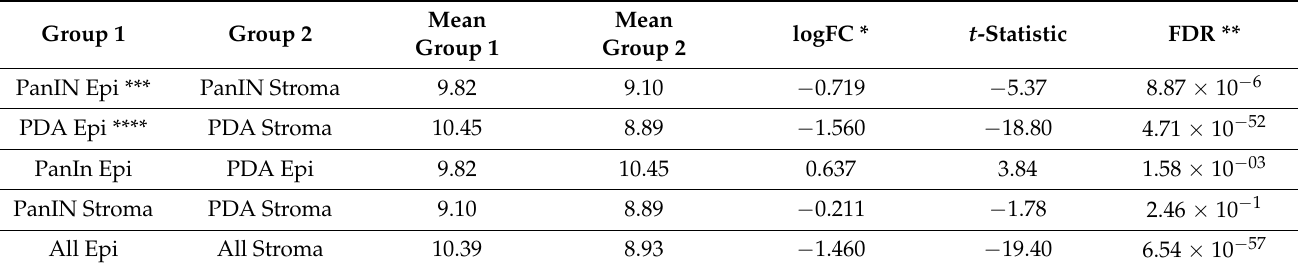
Figure 1. Human primary tumor epithelial cells highly express amyloid precursor-like protein 2 (APLP2). By RNA-Seq analysis, human primary tumor epithelial cells were demonstrated to express significantly more APLP2 than human pancreatic intraepithelial neoplasia (PanIN) epithelial or stromal cells. TPM = Transcripts Per Million. Table 1. Differential APLP2 gene expression